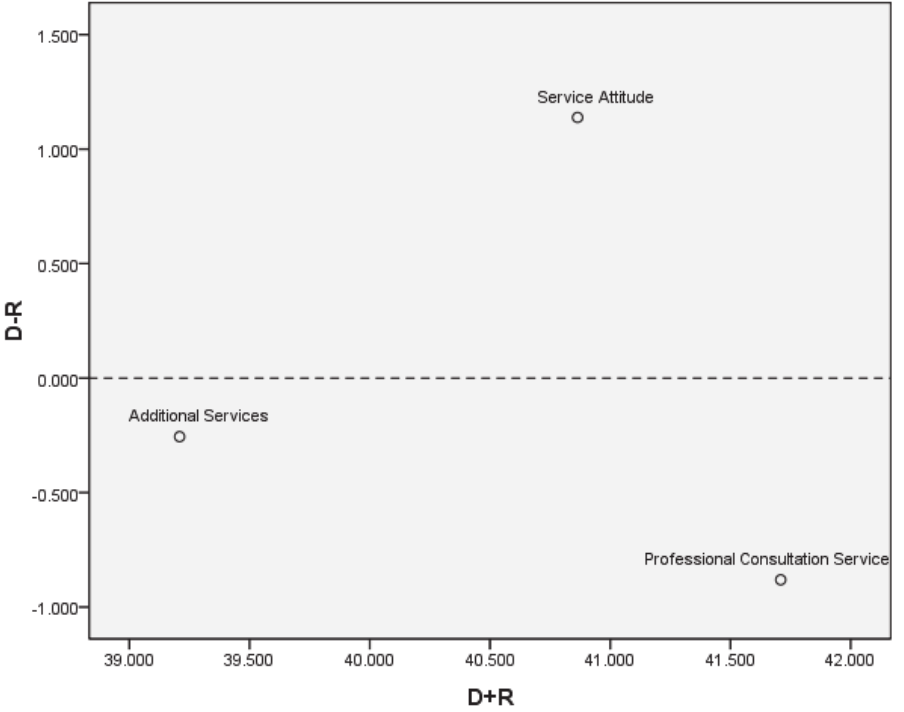
Figure 5. Causal diagram of sub ‐ aspects of customer service perspective criteria .